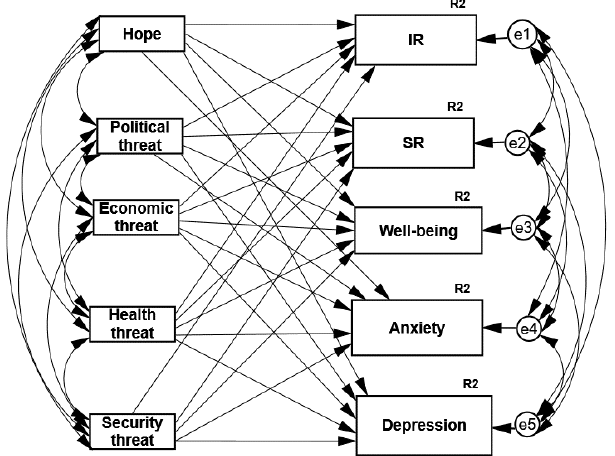
Figure 1. The general theoretical model of the two path analyses—hope and four types of threats pre- dicting individual, societal resilience, well-being, anxiety, and depressive symptoms. IR = individual resilience, SR = societal resilience, R 2 = explained variance . Table 2 . Standardized estimated of path analyses of four type of threats and hope predicting indi- vidual and societal resilience, well-being, anxiety and depressive symptoms during the COVID-19 pandemic ( n = 699) and armed conflict ( n = 647).